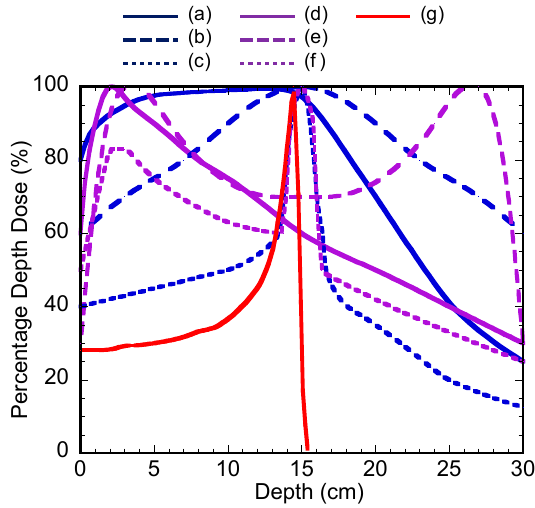
Figure 1. Percentage Depth Dose distributions from 200 MeV electron beams, referring to Monte Carlo simulation results carried out by DesRosiers et al. [8]: ( a ) single-field; ( b ) parallel opposed two-field; ( c ) orthogonal two-field, in comparison with those from a 15 MV photon beam for ( d ) single-field; ( e ) parallel opposed two-field; and ( f ) orthogonal two-field arrangements; and ( g ) 160 MeV single-field proton beam with Bragg peak, illustrated by Friesel et al.